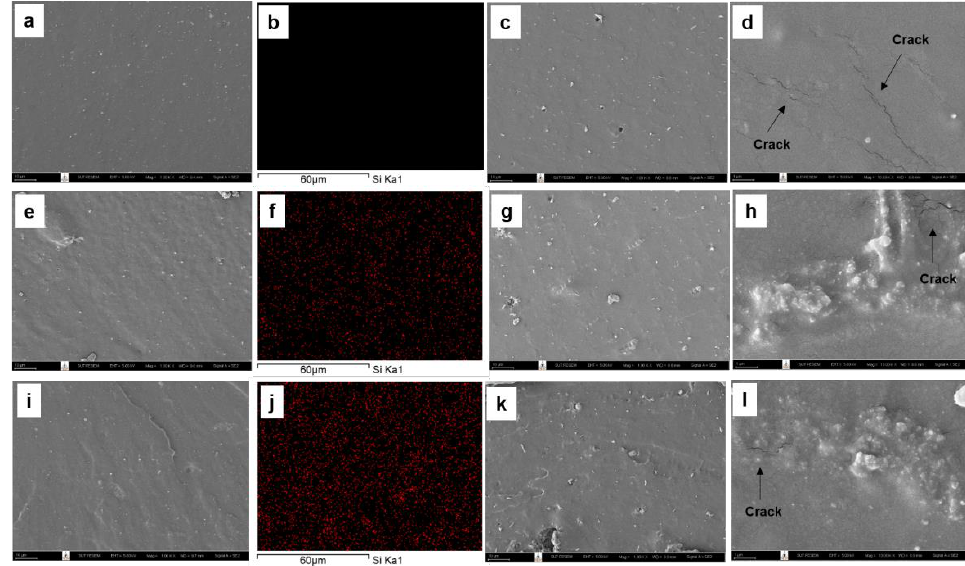
Figure 11. SEM images of freeze fracturing, corresponding EDS (the red spots indicate silica particles), and tensile fracture surface at ×1000 and ×10,000 magnifications of ( a – d ) DPNR; ( e – h ) DPNR-10Si; ( i – l ) DPNR-20Si.